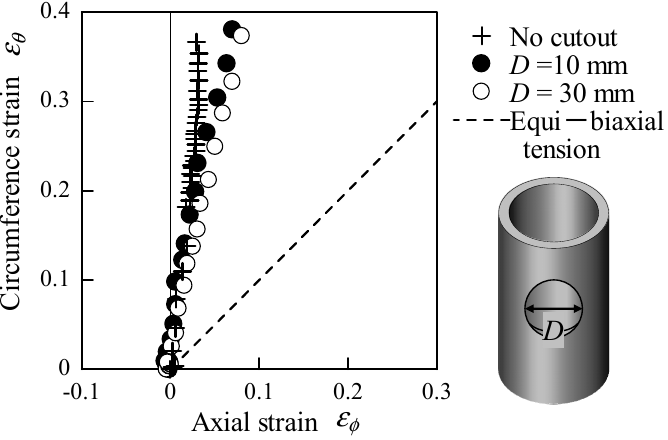
Figure 12. Strain paths obtained by specimens with round cutouts.